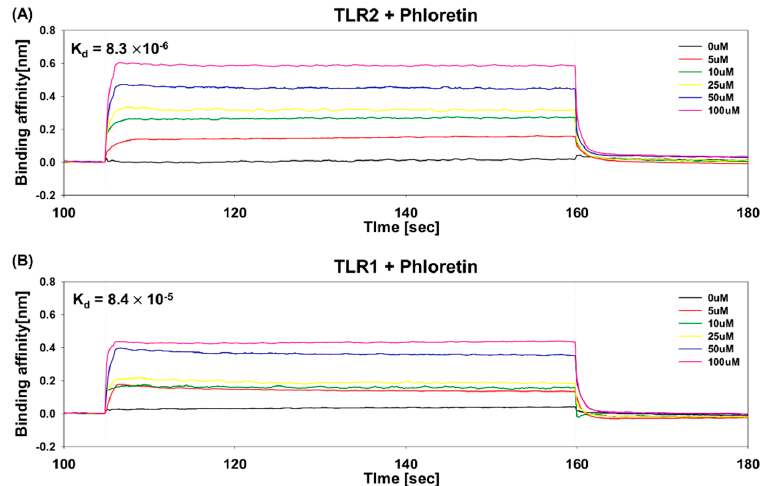
Figure 5. Binding of phloretin to TLR2 ( A ) and TLR1 ( B ) determined by bio-layer interferometry. Representative curves showing the phloretin association to and dissociation from immobilized TLR2 at various concentrations of phloretin (0, 5, 10, 25, 50, and 100 µM). Dissociation constant, K d in M is marked in the figures.